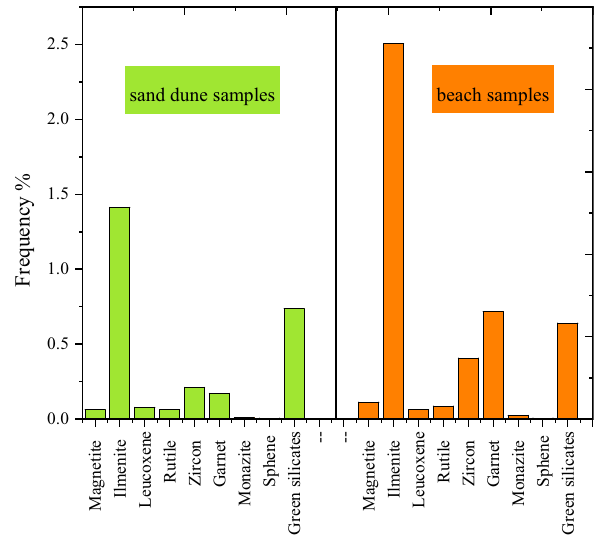
Figure 6. Frequency % of each individual heavy mineral among the study